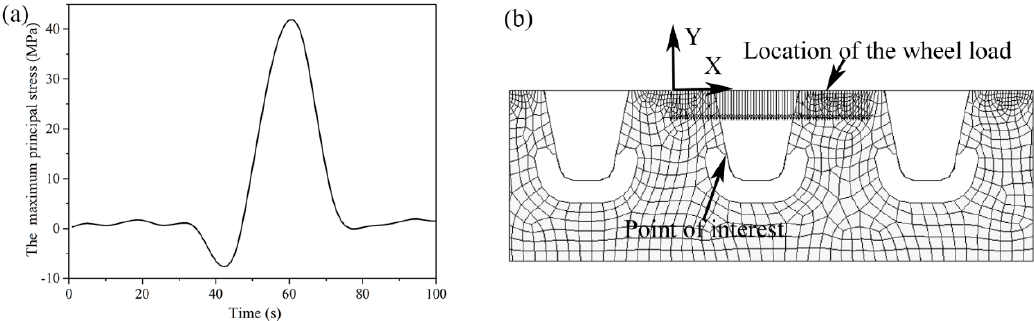
Figure 3. ( a ) Maximum principal stress–time curve of the interest point, and ( b ) the position of wheel load as the maximum principal stress of the interest point reaches its peak.